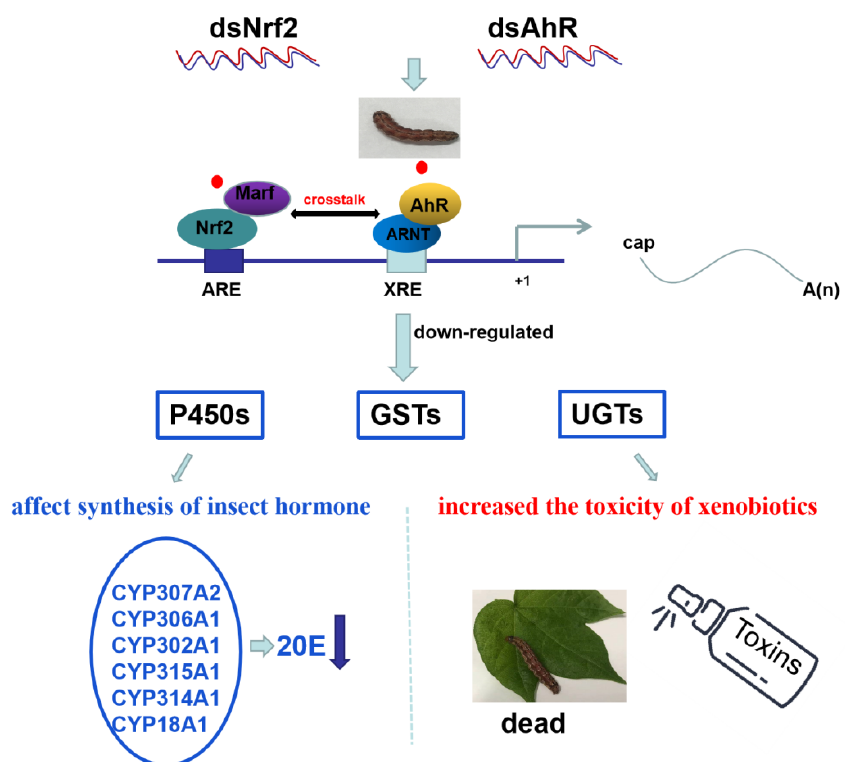
Figure 9. A schematic illustration of the proposed model of how the crosstalk between HaNrf2 and HaAhR regulate the P450s, GSTs and UGTs genes and mediate the susceptibility of xenobiotics in H. armigera . Xenobiotics are represented by a red dot.